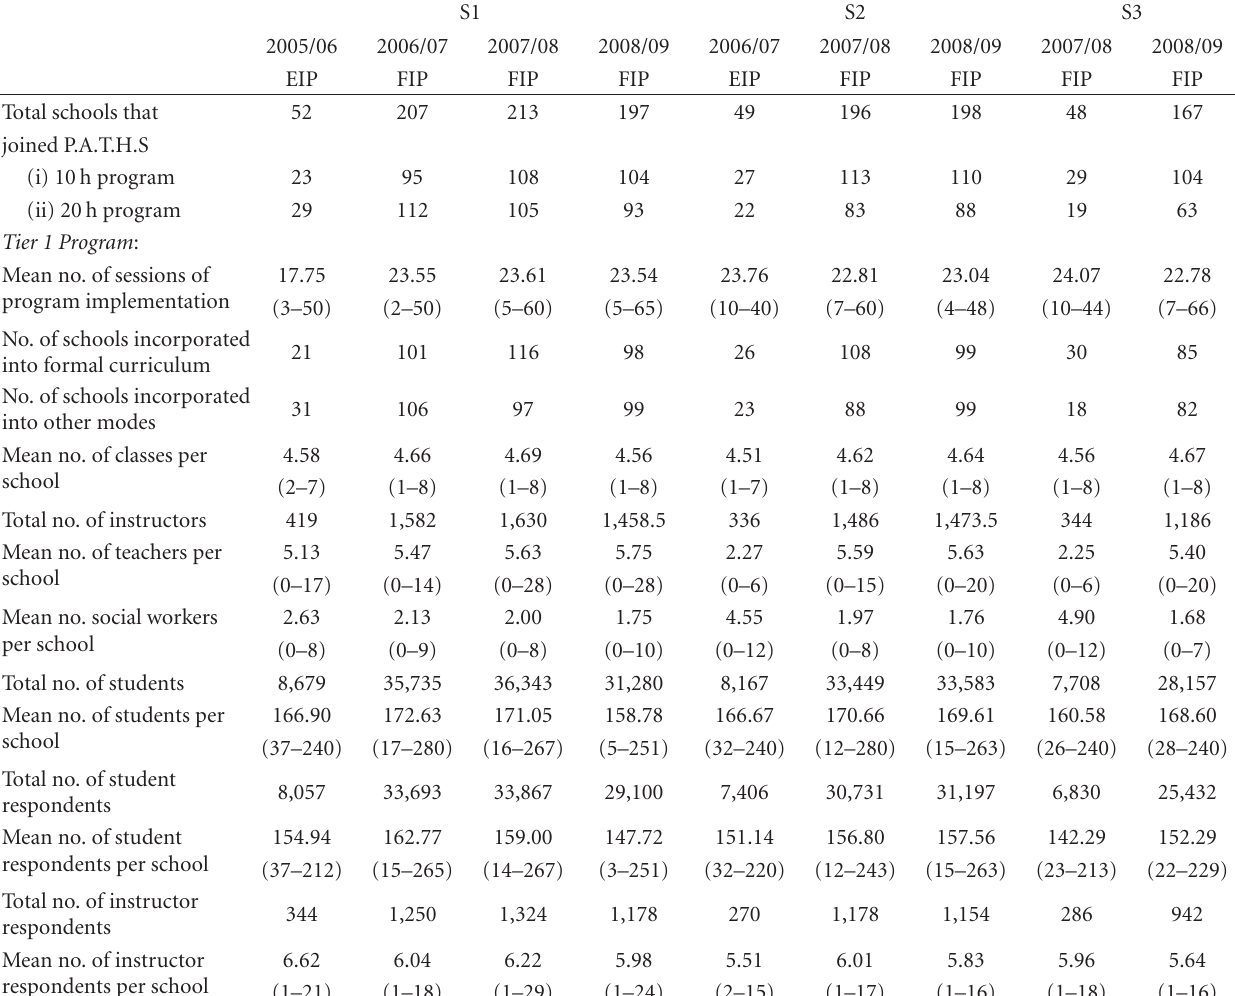
Table 1: Description of data characteristics from 2005 to